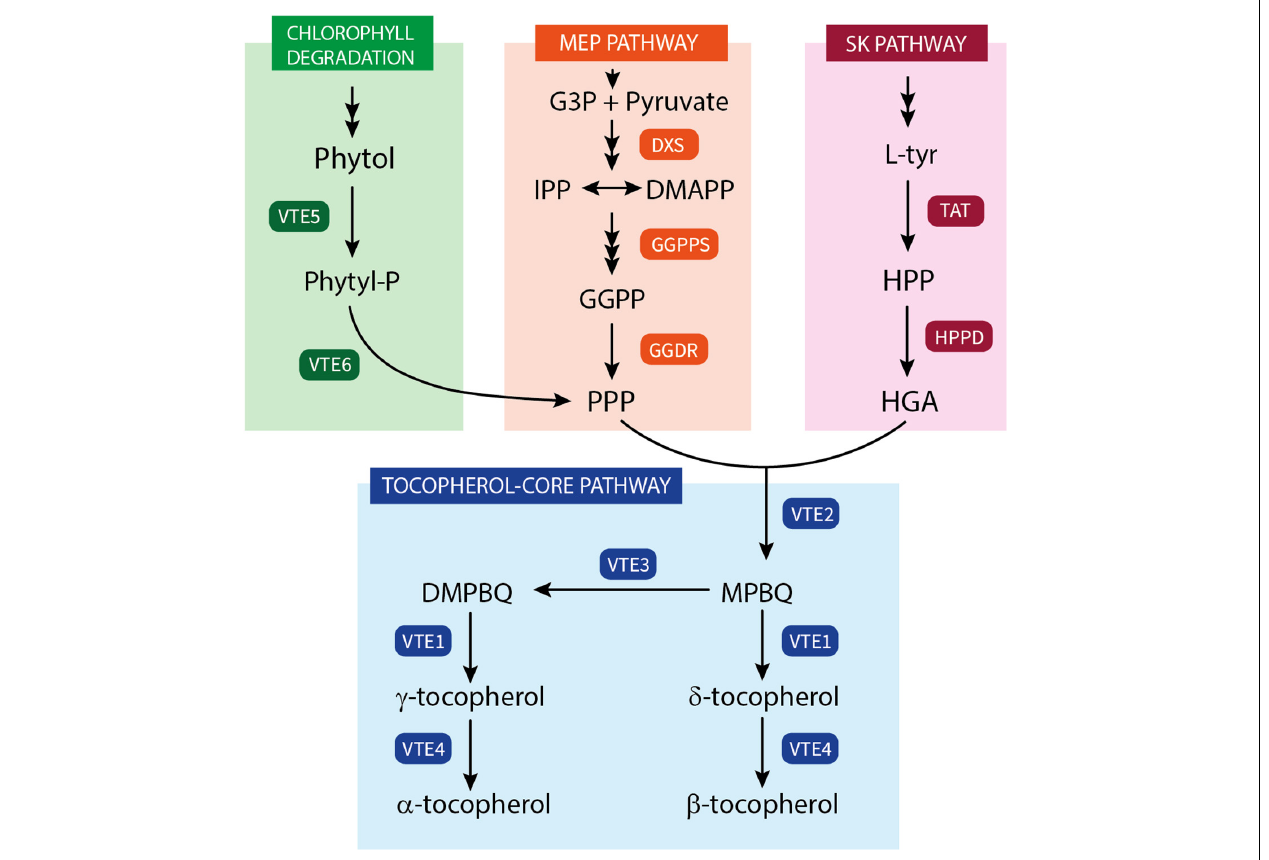
FIGURE 1 | Schematic representation of tocopherol biosynthetic pathway in plants. Phytyl-P, phytyl phosphate; G3P, glyceraldehyde 3-phosphate; IPP, isopentenyl diphosphate; DMAPP, dimethylallyl diphosphate; GGPP, geranylgeranyl diphosphate; PPP, phytyl pyrophosphate; L -Tyr, amino acid L -tyrosine; HPP, 4-hydroxyphenylpyruvate; HGA, homogentisate; MPBQ, 2-methyl-6-phytyl-1,4-benzoquinol; DMPBQ, 2,3-dimethyl-6-phytyl-1,4-benzoquinol; VTE5, phytol kinase; VTE6, phytyl-P kinase; DXS, 1-deoxy- D -xylulose-5-phosphate synthase; GGPPS, GGPP synthase; GGDR, GGPP reductase; TAT, tyrosine aminotransferase; HPPD, HPP dioxygenase; VTE2, homogentisate phytyltransferase (HPT); VTE3, MPBQ methyltransferase (MPBQ-MT); VTE1, tocopherol cyclase (TC); VTE4, tocopherol methyltransferase ( γ